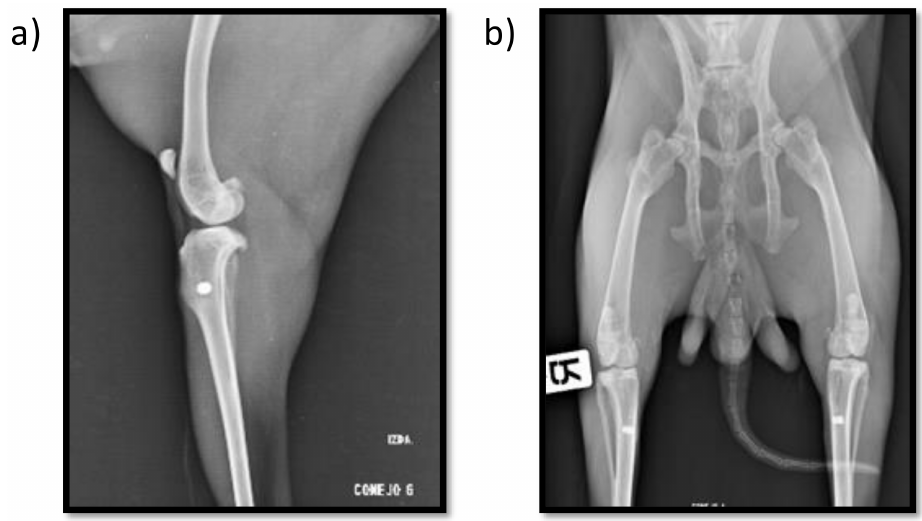
Figure 1. Mediolateral ( a ) and craniocaudal ( b ) postoperative X-ray images showing both insertion point location and implant alignment.